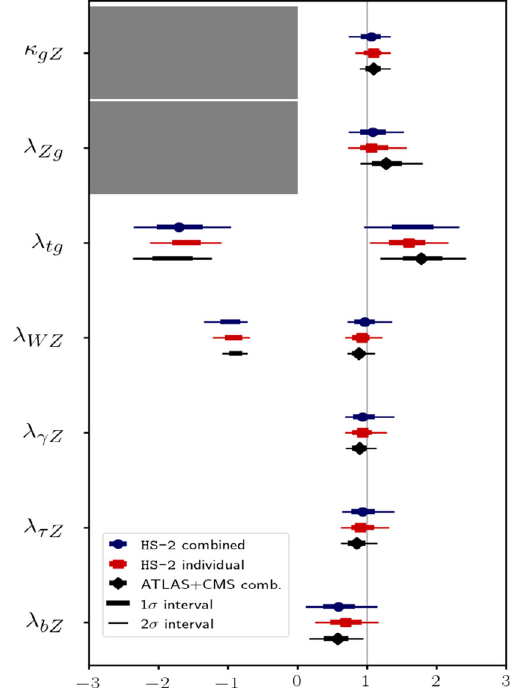
Fig. 7 Official and reproduced ATLAS and CMS combined Run-1 results for ratios of Higgs coupling scale factors. The results obtained with HiggsSignals-2 usingthecombinedATLASandCMSdataas input and the results using the individual signal strength measurements asinputareshown inblueandred, respectively,whiletheofficialresults are shown in black. The error bars indicate the 1 σ (thick lines) and 2 σ (thin lines) intervals. The gray areas indicate the parameters that are assumed to be positive